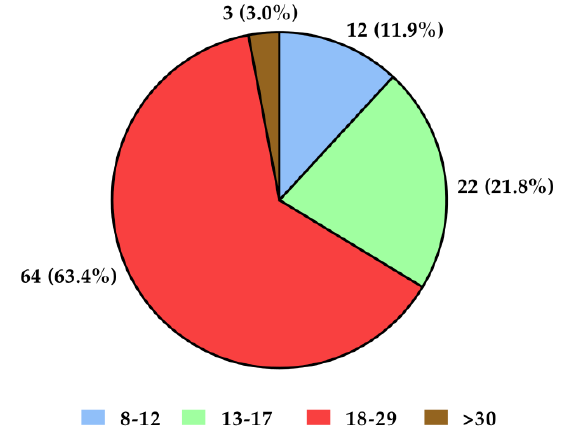
Figure 1. Comparison of the study: ( a ) and control ( b ) groups by age and gender.